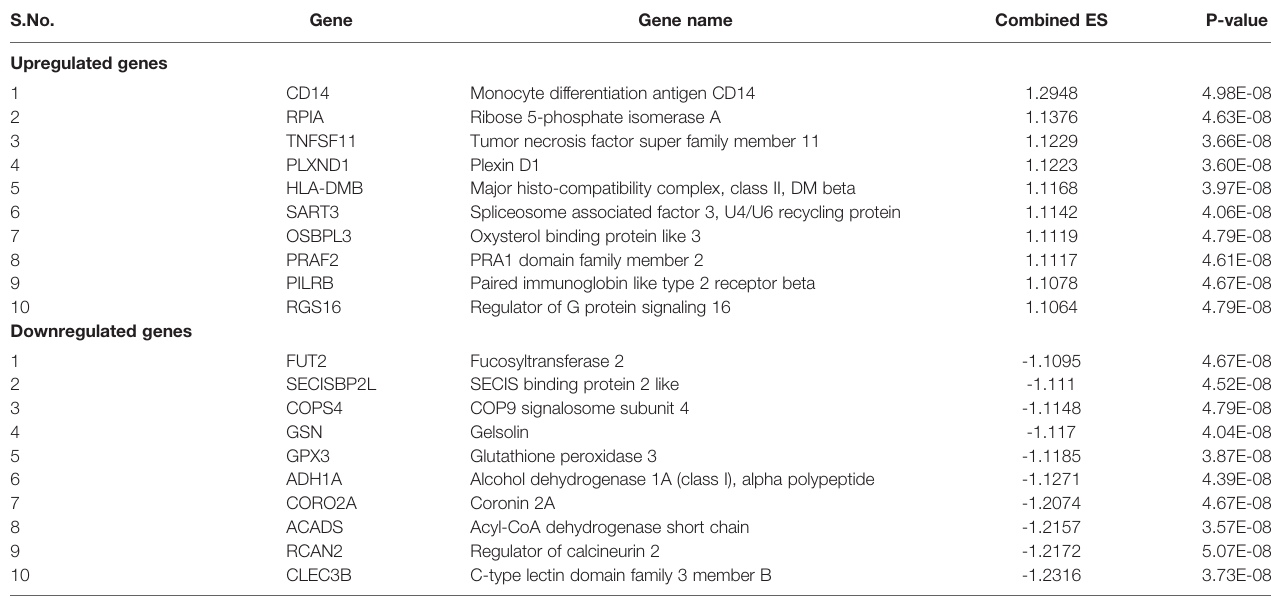
TABLE 2 | Top ten up- and downregulated